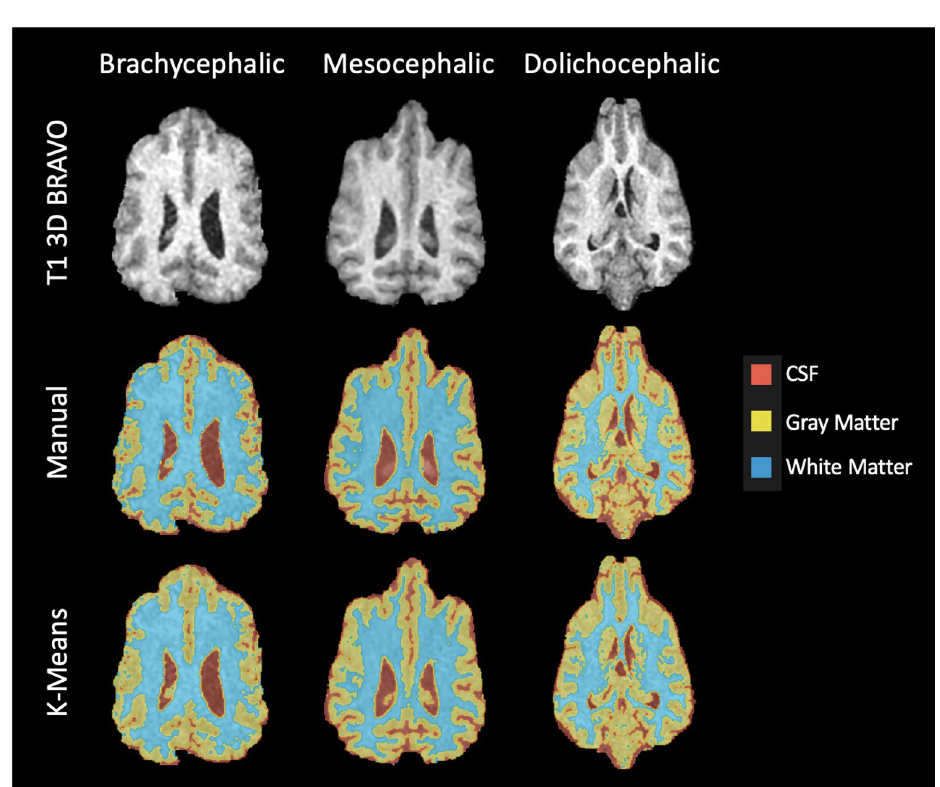
Figure 7. Segmentation of the white matter, gray matter and cerebrospinal fluid (CSF), on three dogs of different cranial conformation (brachycephalic, mesocephalic, dolicocephalic). The acquired T1 3D BRAVO image is compared with manual segmentation and automatic segmentation using K -Means